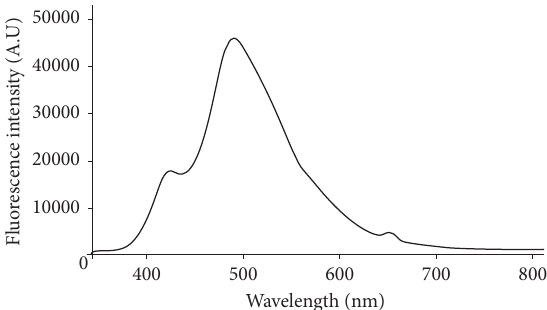
Figure 3: Optimization of integration time for levofloxacin. Condition: concentration 25 μ g · mL − 1 ; integration time: 600mS.